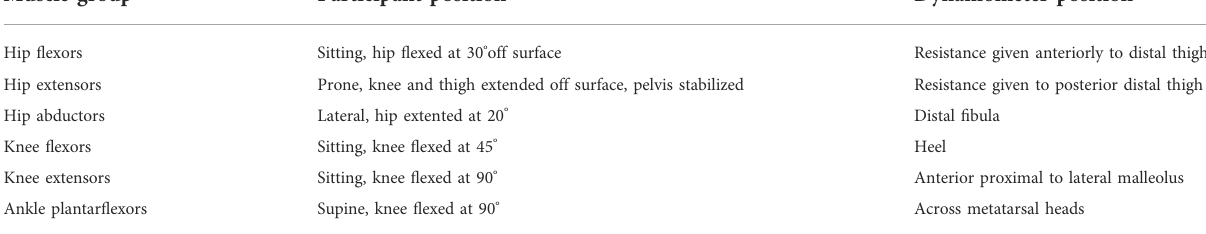
TABLE 1 Muscle strength testing protocol.